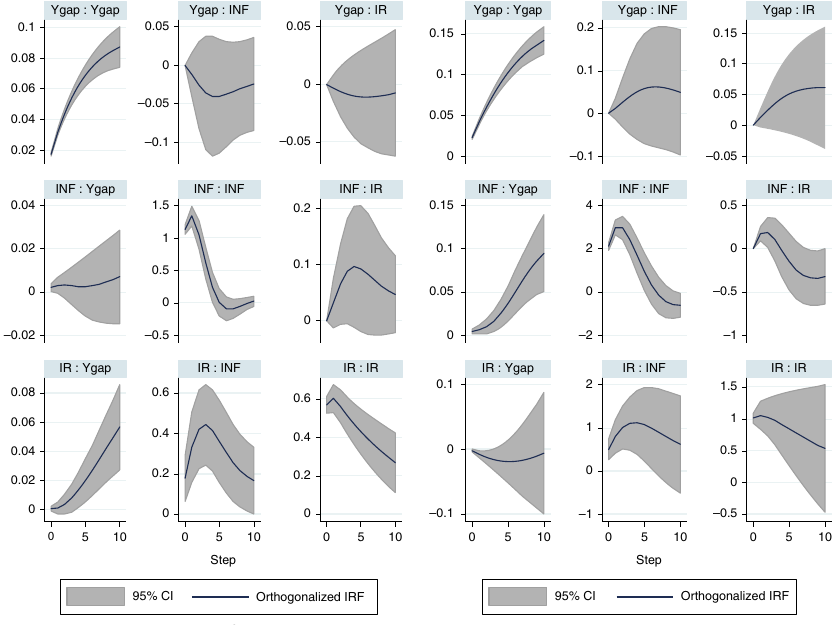
Figure 2. Graphs of impulse responses